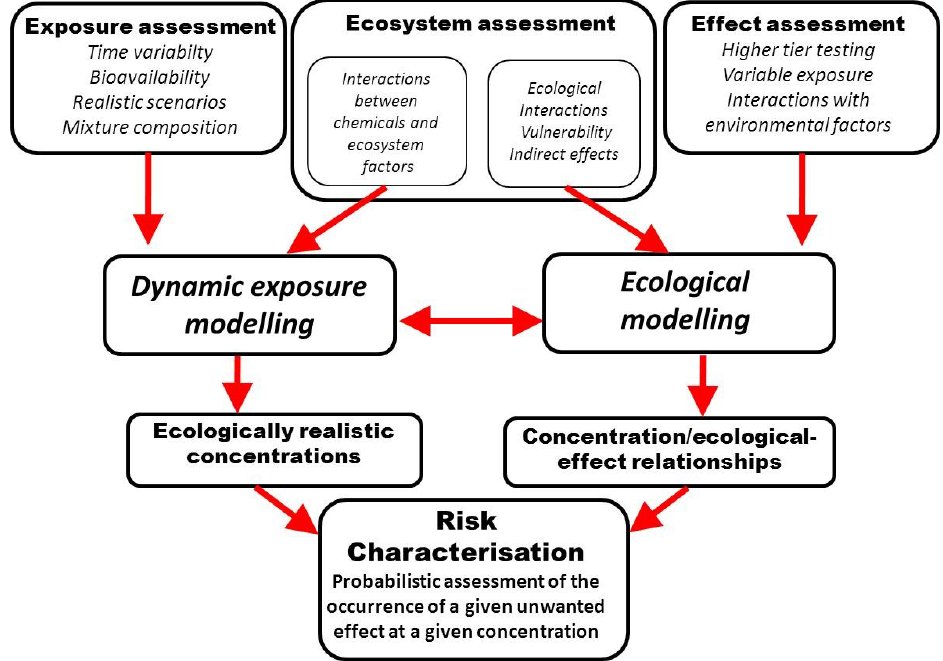
Figure 2. A proposal for a more ecologically-based procedure for ecological risk assessment (modified after